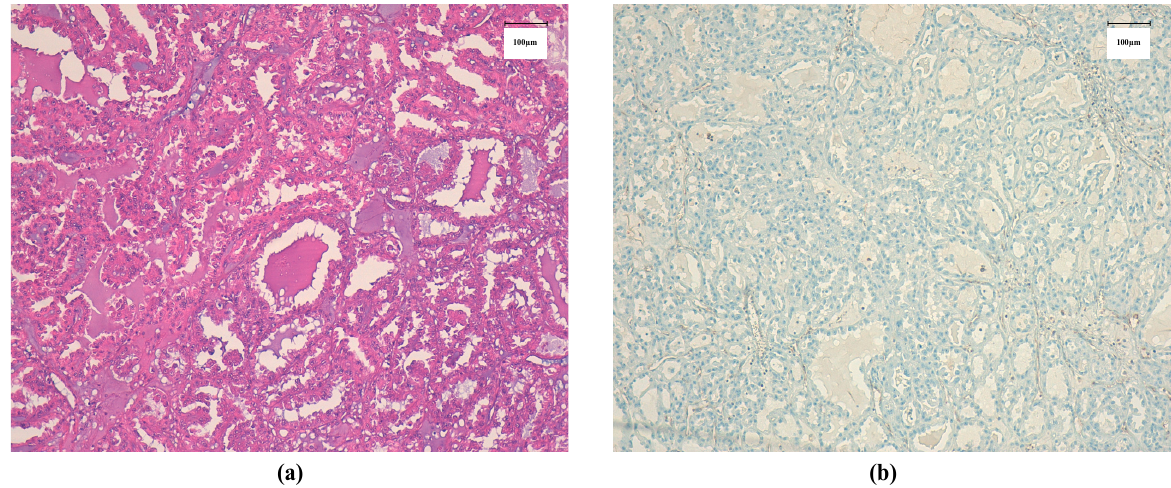
Figure 2. Biopsy showing papillary and tubular renal carcinoma. ( a ): Histological section with he- matoxylin-eosin stain showing renal cell carcinoma with eosinophilic nucleolus surrounded by per- inuclear halo. ( b ): Histological section showing loss of expression of FH. Scale bars 100 µm.